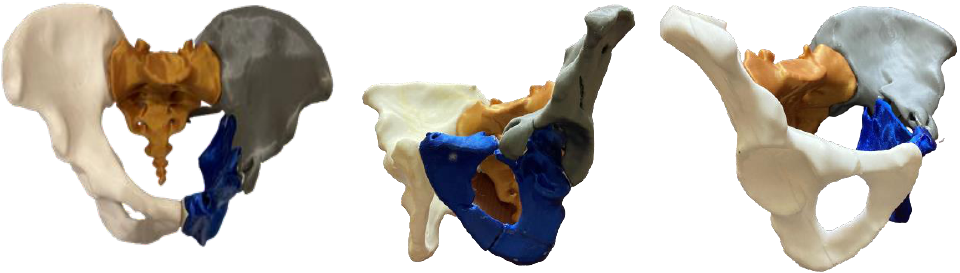
Figure 1. A 3D printed pelvis model of a clinical case with a complex acetabular fracture is illus- trated in inlet ( left ), obturator oblique ( middle ), and iliac oblique ( right ) views.